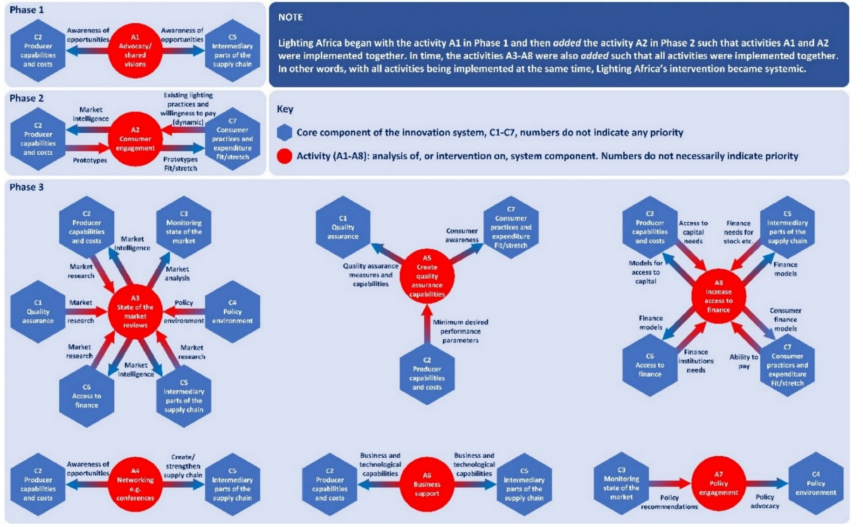
Figure 1. An illustrated conceptualisation of how Lighting Africa transformed access to solar lanterns in